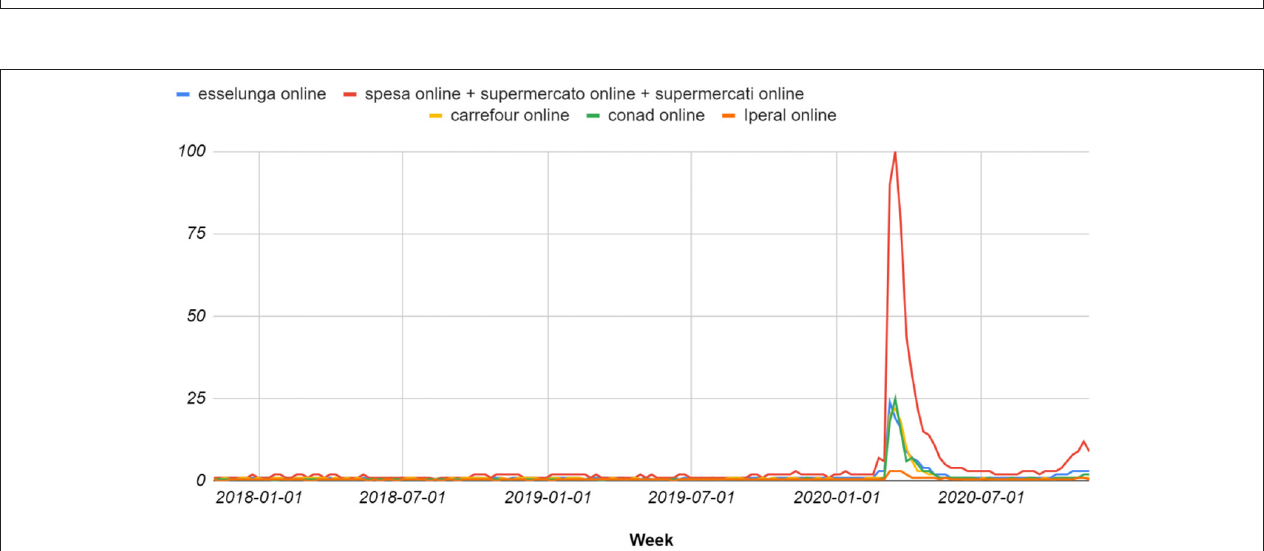
FIGURE 1 | Italian citizens’ web interest in home food delivery services from November 2017 to November 2020.